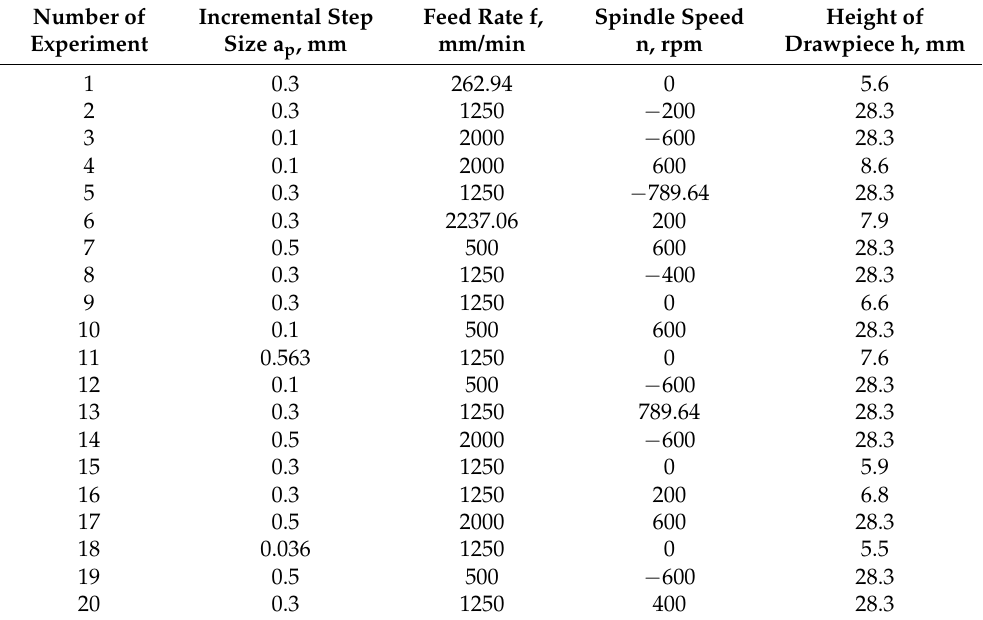
Table 4. Central composite design of experiments.